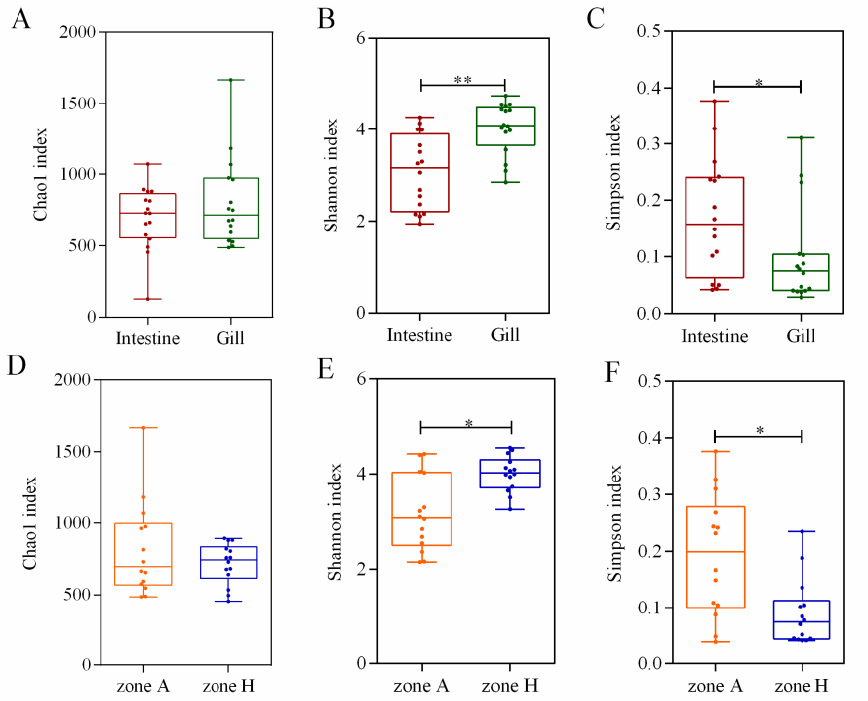
Figure 2. The Alpha diversity analysis of microbiota at the OUT level. ( A – C ) Chao1, Shannon, and Simpson indexes, analysis based on different tissues. The red dots on the box plot represented a sum of intestine samples from two zones. The green dots represented a sum of gill samples from two zones. ( D – F ) Chao1, Shannon, and Simpson indexes, analysis based on different zones. The orange dots on the box plot represented a sum of gill and intestine samples from zone A. The blue dots represented a sum of gill and intestine samples from zone H. “*” indicated p < 0.05 and “**” indicated p < 0.01.